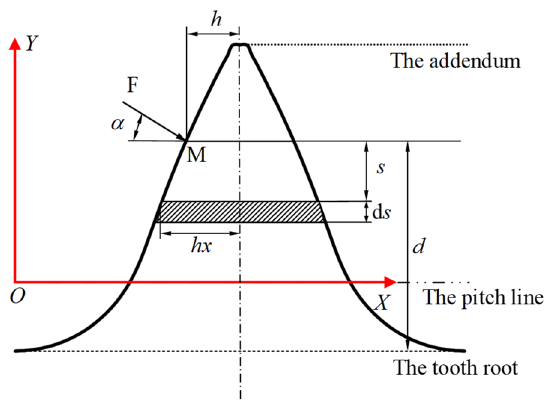
Figure 21. Force diagram of rack.